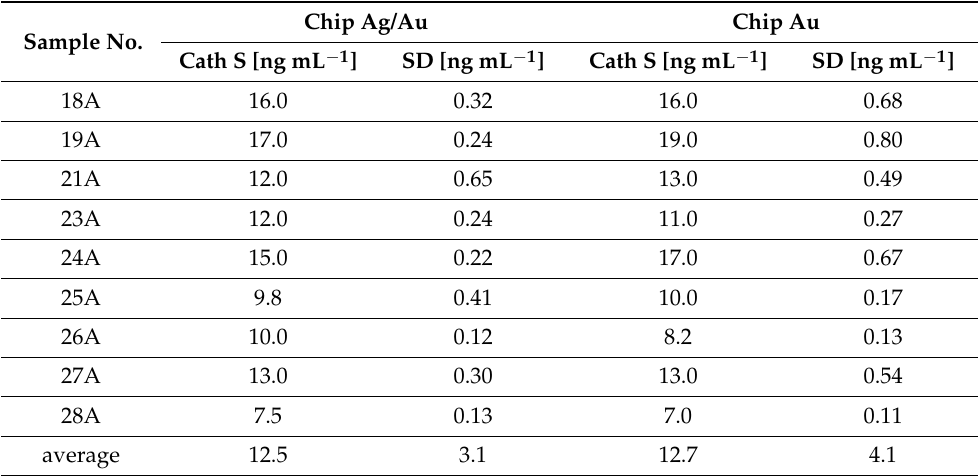
Table 3. Cathepsin S in blood plasma samples of ovarian cancer patients as determined by biosensors formed on Ag/Au and Au chips. Sample